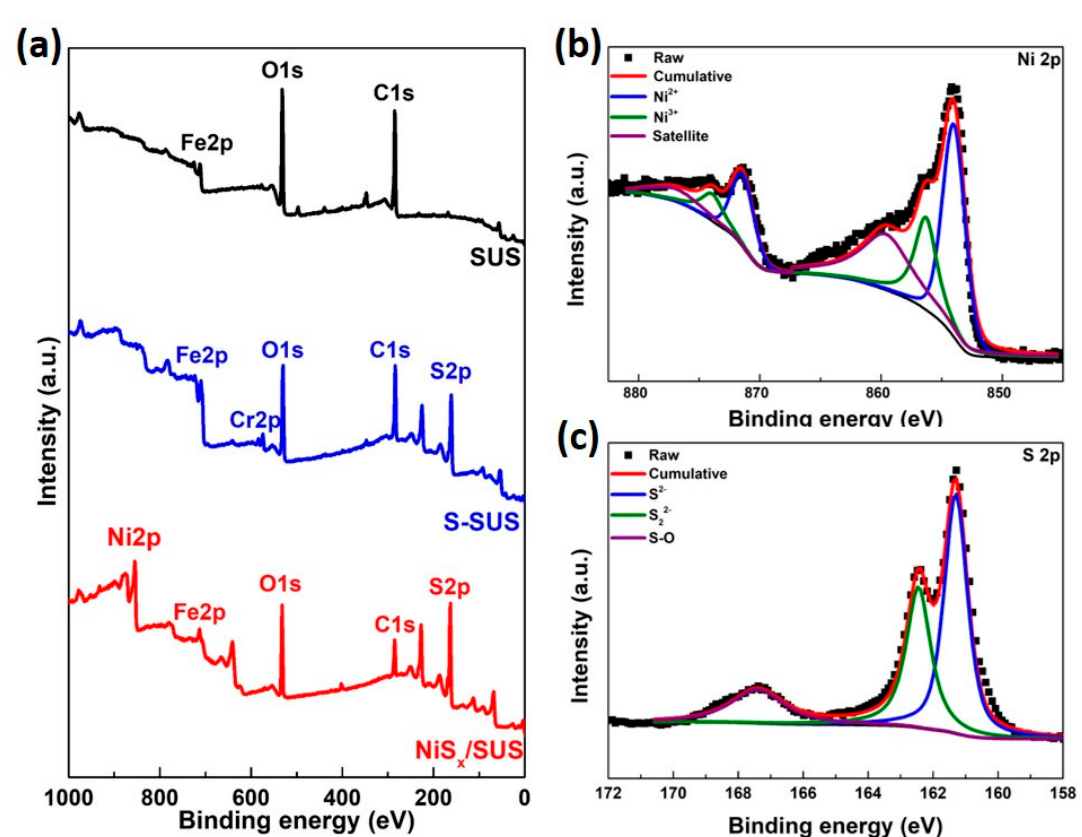
Figure 4. X-ray photoelectron spectroscopy of prepared electrodes. ( a ) Survey spectra of SUS (black), S-SUS (blue), and NiS x /SUS (red); ( b ) high resolution XPS scans of Ni 2p; and ( c ) S 2p from NiS x /SUS.